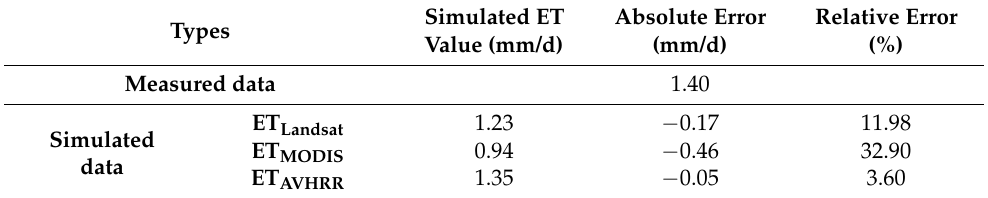
error, which was more than twice the RE between the high-resolution daily estimated ET and the observational data (AE = − 0.46 mm/d, RE = 32.90%). Table 4. Comparison of the simulated ET with the measured ET data for 7 August 2011. Types